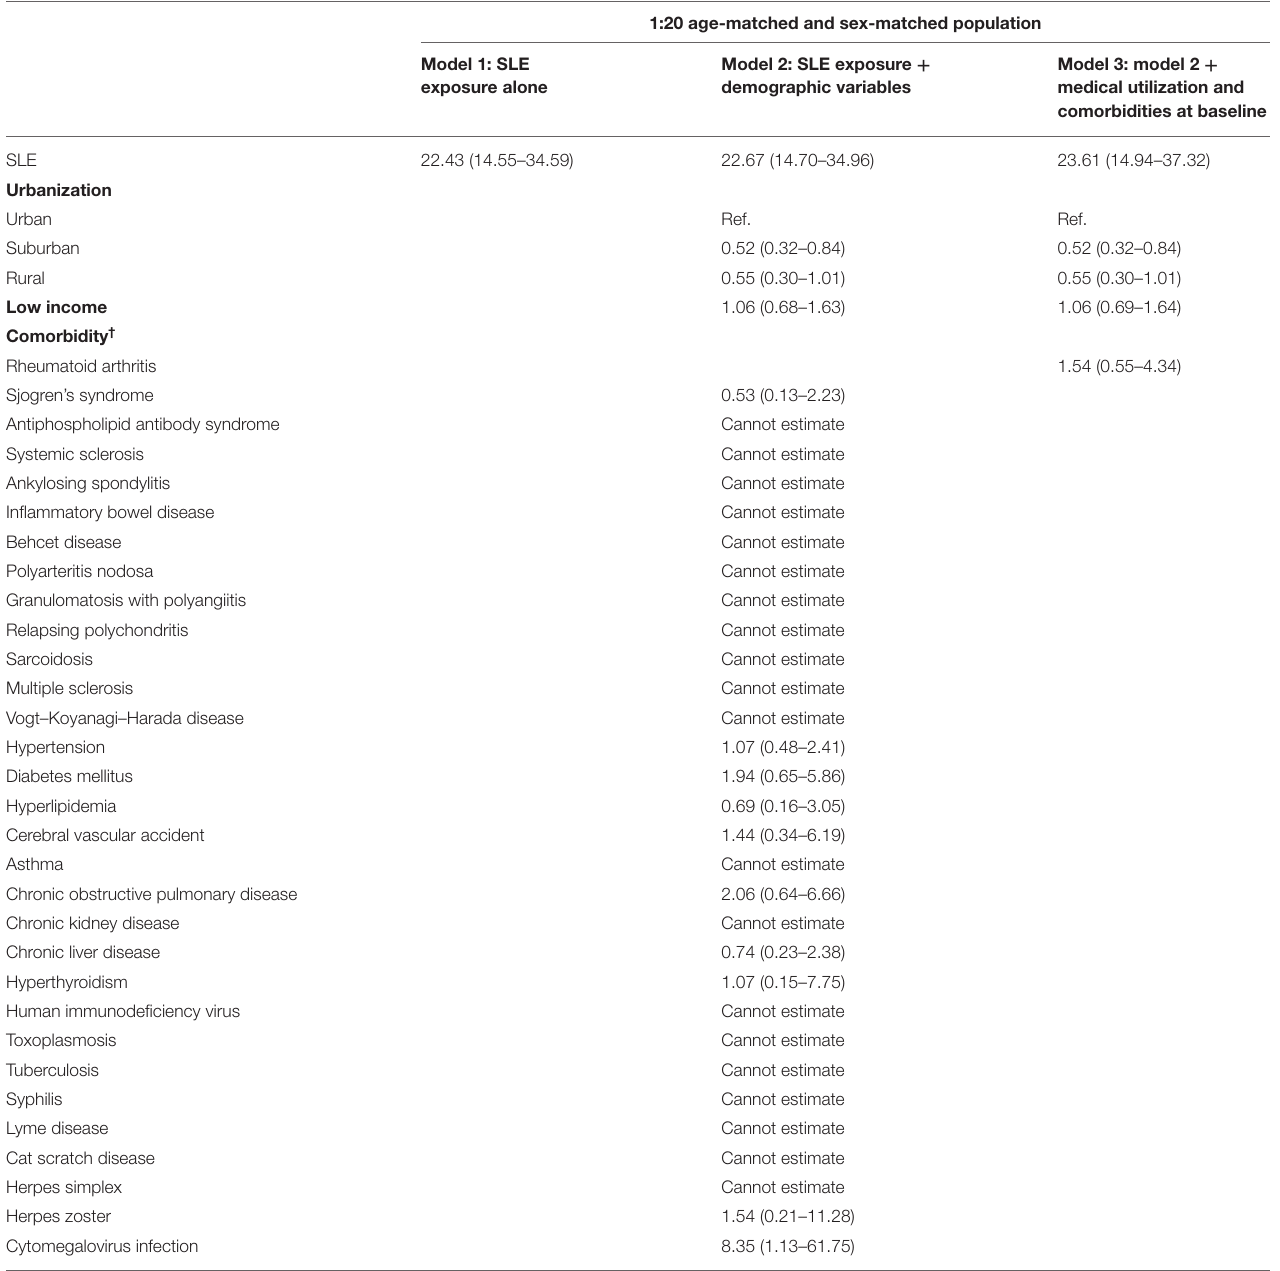
TABLE 3 | Cox proportional hazard regressions for estimation of adjusted HRs on retinal vasculitis.